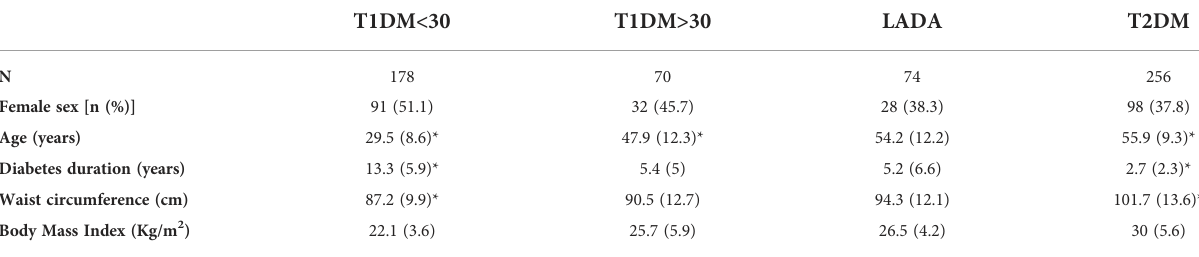
TABLE 2 Characterization of the participants according to type of